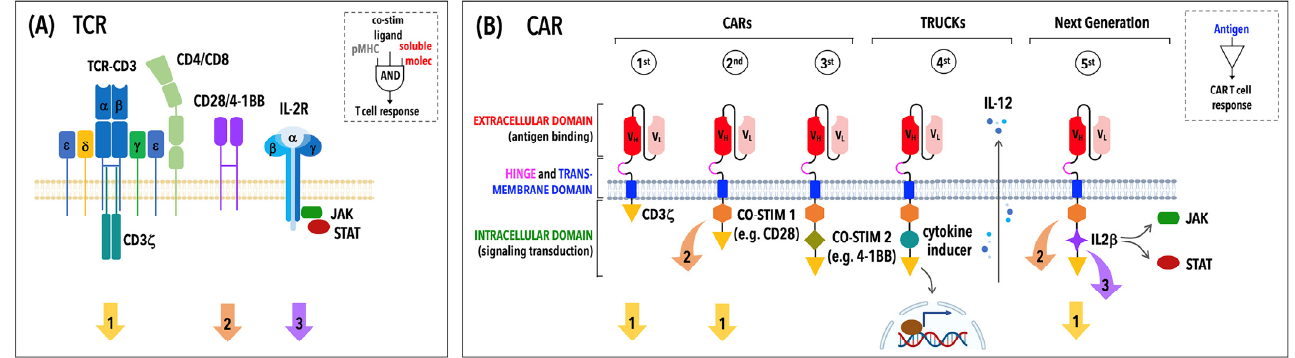
Figure 1. TCR versus CAR: signaling differences reflect structural differences. ( A ) The TCR is a multi-subunit complex consisting of an αβ heterodimer responsible for antigen recognition and a conserved signaling module, the CD3 complex. Full T cell activation requires not only the recognition of a cognate antigen in the form of a pMHC complex (signal 1) but also a co-stimulatory signal (signal 2) mediated by molecules, such as CD28 or 4-1BB, and soluble factors, known as cytokines (signal 3), driving T cell differentiation and function. A co-receptor, CD4 or CD8, contributes to sustaining TCR signaling by stabilizing TCR–pMHC interactions and by recruiting signaling molecules and adaptors to engaged TCRs. ( B ) The CAR contains an extracellular scFv derived from a monoclonal antibody specific for a tumoral antigen that is linked to intracellular signaling domains through a hinge and a transmembrane portion. The cytoplasmic tail of a first-generation CAR contains a single CD3 ζ -derived signaling module, while those one of subsequent CAR generations include co-stimulatory signaling domains (i.e., CD28 and/or 4-1BB). Consistent with the CAR structure, both signal 1 and 2 are triggered by antigen binding, while signal 3 is mediated by endogenous cytokine receptors, with the exception of fifth-generation CARs that incorporate a truncated intracellular domain of a cytokine receptor. Notably, TRUCKs or fourth-generation CARs are CAR-redirected T cells used to produce and release pro-inflammatory cytokines, which have an indirect effect on the T cell by modulating the tumor stroma and improving the overall anti-tumor